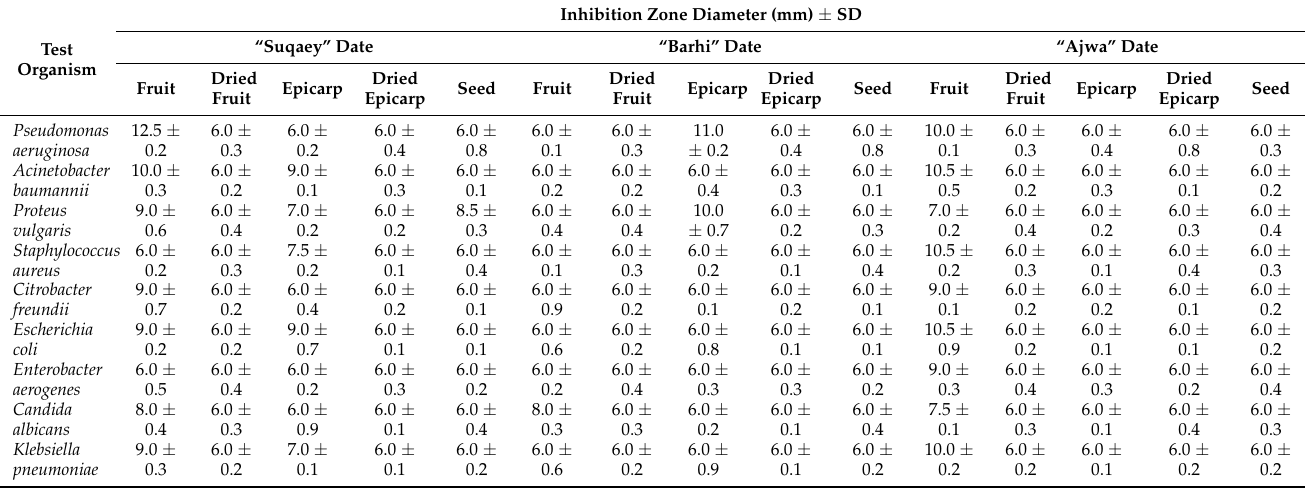
Table 2. Antimicrobial effects of Saudi Arabian date extracts against some